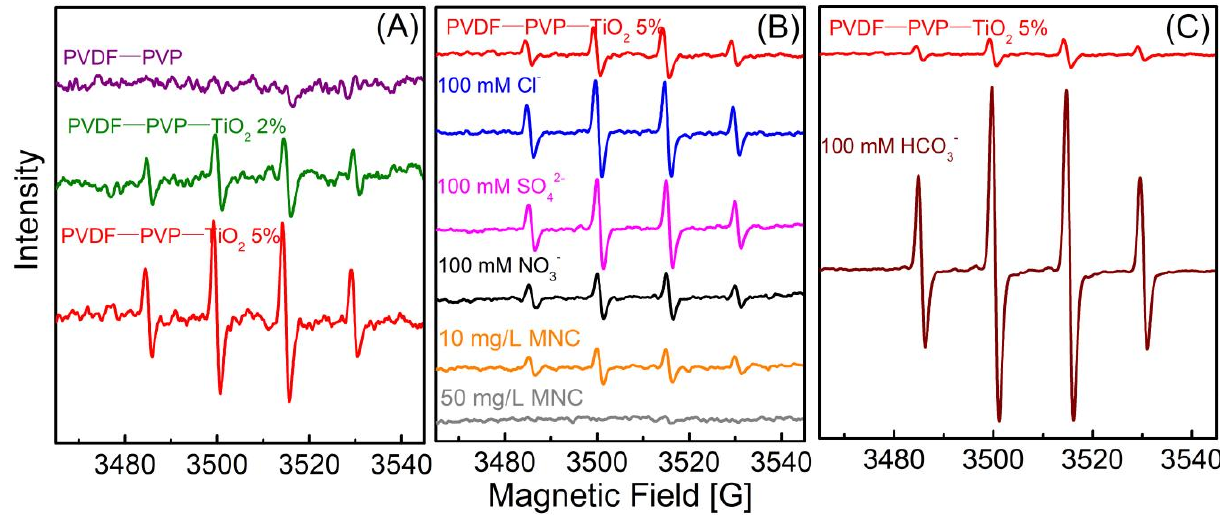
Figure 5. ESR spectra of ( A ) fiber mats (PVDF–PVP, PVDF–PVP–TiO 2 2%, and PVDF–PVP–TiO 2 5%) in DI water, ( B ) PVDF–PVP–TiO 2 5% with different solutions (DI water, 100 mM NaCl, 100 mM Na 2 SO 4 , 100 mM NaNO 3 , 10 mg/L minocycline (MNC), and 50 mg/L MNC), and ( C ) PVDF–PVP–TiO 2 5% with DI water and 100 mM NaHCO 3 .